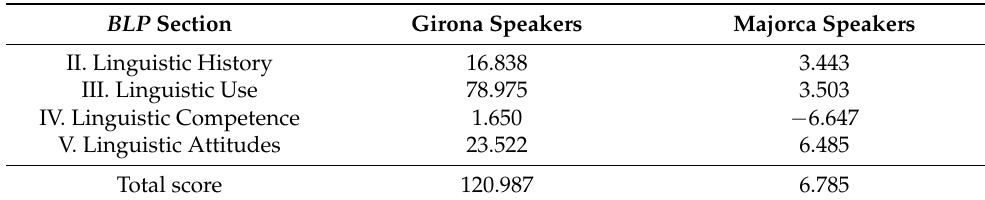
Table 7. Mean scores in the BLP questionnaire for Girona and Majorca participants. Results for each section and final scores are